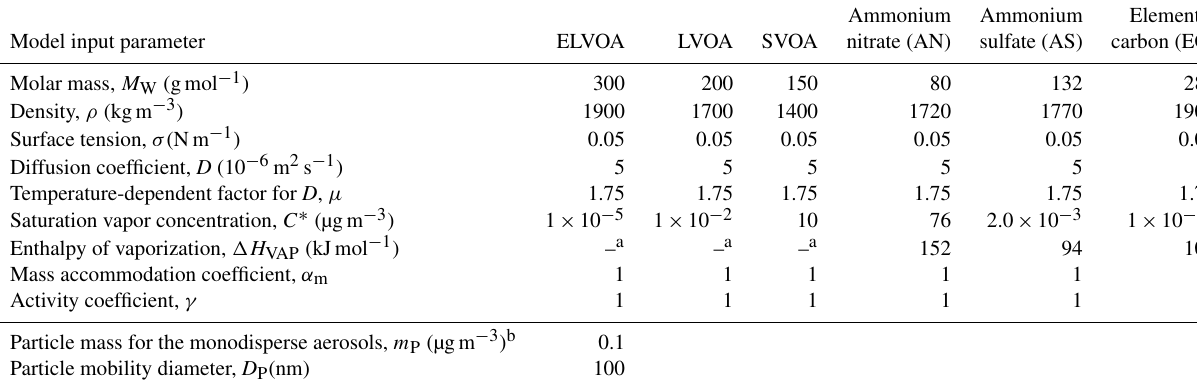
Table 1. Properties of six particle components used as input for the evaporation model.